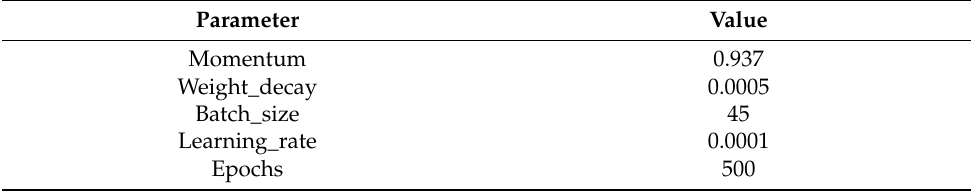
Table 1. Training parameter settings.